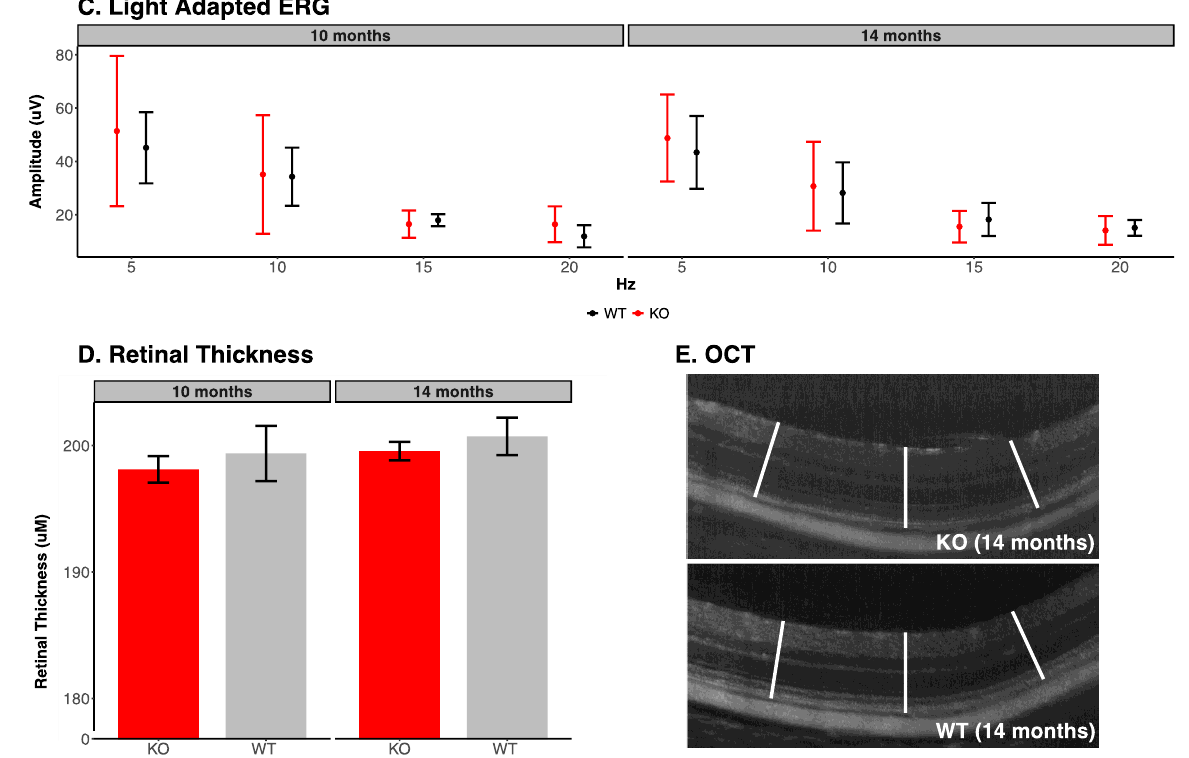
Figure 1. Full-field electroretinogram (ERG) and optical coherence tomography (OCT) findings in Epm2a −/− knock out (KO) mice and control (WT) littermates. ( A ) Dark-adapted (DA) ERG a-wave amplitude measures to different intensities of flash (ranging from 0.01 cd·s·m −2 to 10 cd·s·m −2 ) showed no difference between KO and WT mice at both 10 months and 14 months of age. ( B ) The DA ERG b-wave amplitude measures to different intensities of flash (ranging from 0.0025 cd·s·m −2 to 10 cd·s·m −2 ) showed no difference between KO and WT mice at both time points. ( C ) Light-adapted (LA) ERG amplitude measures to four different flicker frequencies (5–20 Hz) showed no difference between KO and WT mice at both time points. Notably, the LA flicker amplitudes are lower at higher stimulus frequencies (15 and 20 Hz) compared to lower stimulus frequencies (5 and 10 Hz) in both KO and WT mice. This is because the depolarizing bipolar cell contribution that predominates the LA ERG at lower flicker frequencies shows larger amplitudes compared to the hyperpolarizing bipolar cell contribution that predominates at high flicker frequencies. Similar findings have been consistently observed in multiple WT mouse models. ( D ) The average retinal thickness was comparable between KO and WT mice at both time points. ( E ) A representative horizontal line scan from KO and WT mice, respectively, showing how the average retinal thickness was calculated.